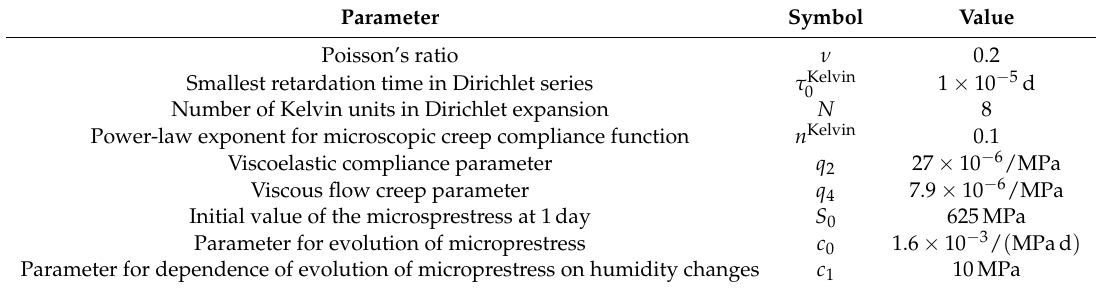
Table 7. Parameters for the creep formulation